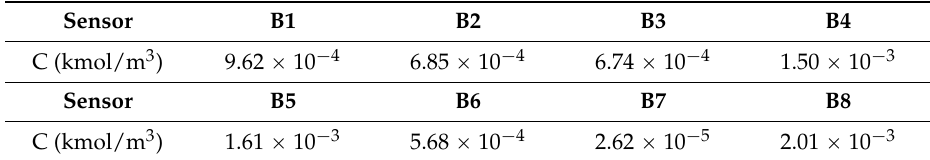
Table 15. The measured concentration of deployment scheme based on DE algorithm.